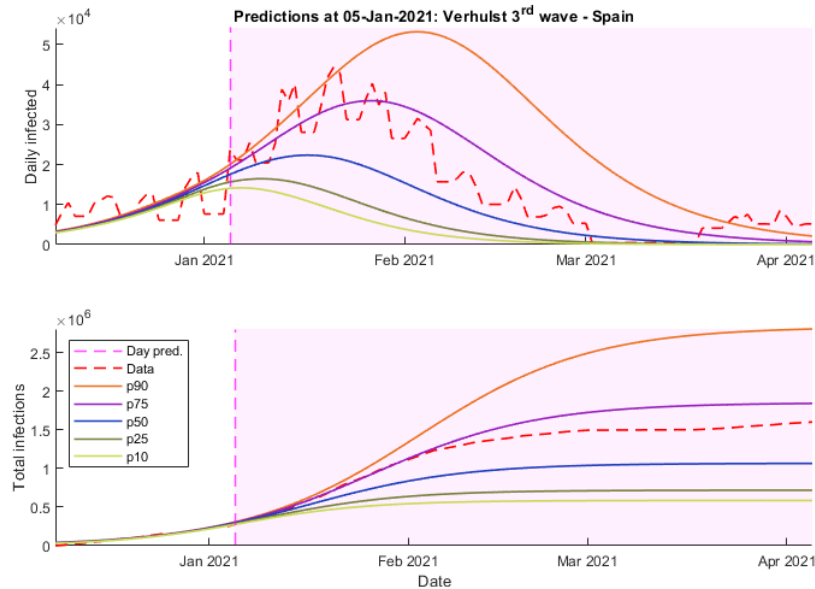
Figure 8. Predictions 5 January 2021 wave 3 Verhulst — Spain.